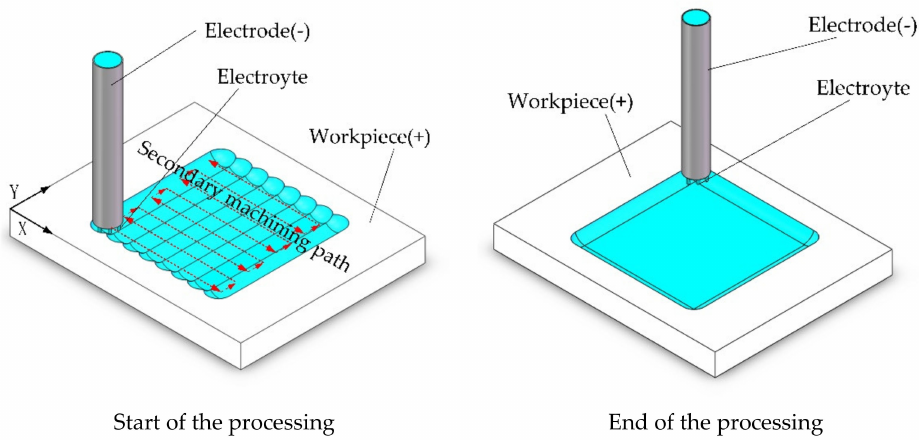
Figure 15. Diagram showing secondary processing.